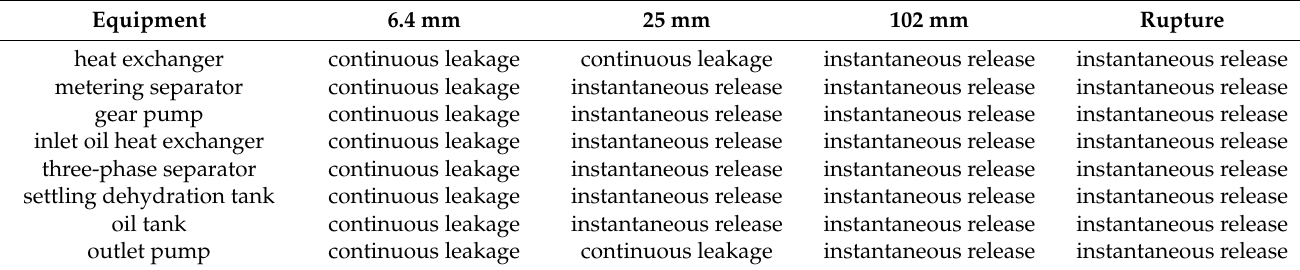
Table 7. Leakage rate and total leakage of equipment.